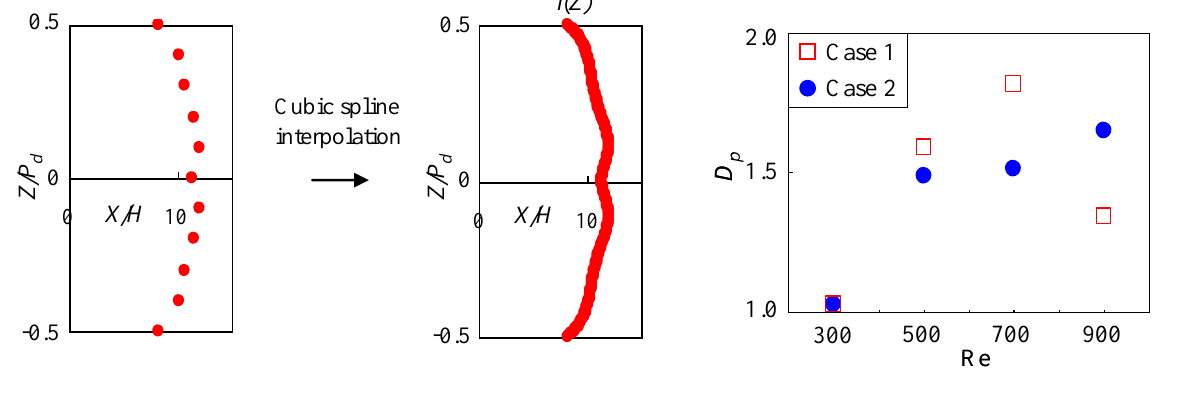
Fig. 12 Schematic of cubic spline interpolation of reattachment points in spanwise direction.